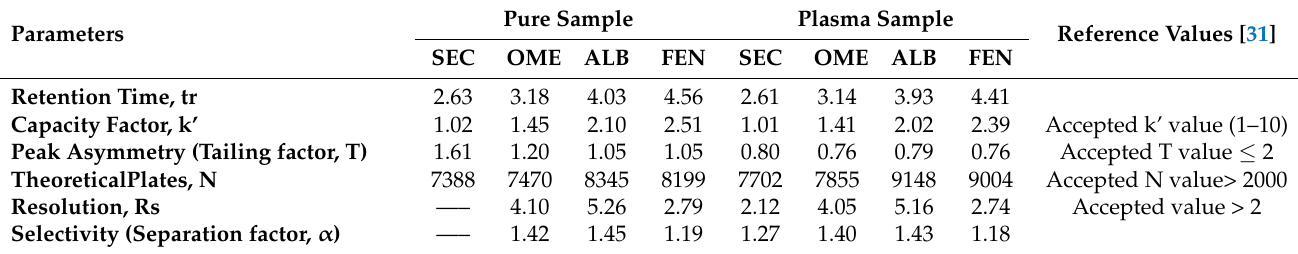
Figure 5. HPLC chromatogram of ( A ) blank human plasma sample, and ( B ) mixture of 1 µg/mL SEC, OME, ALB, and FEN in human plasma sample. All optimum chromatographic conditions are stated in Table 1. Table 2. System suitability parameters for SEC, OME, ALB, and FEN, in both pure and plasma samples.